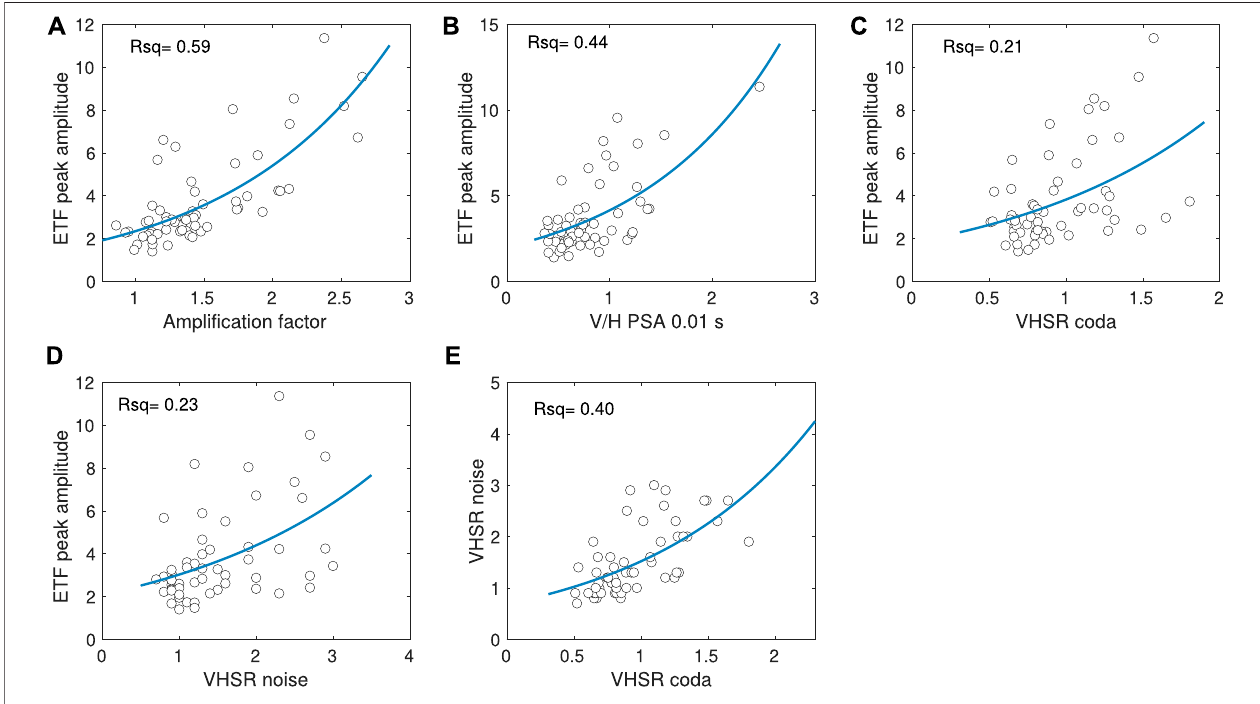
FIGURE 12 | Each panel depicts the correlation between the ETF and (A) Ampli fi cation factor from maximum amplitudes of earthquake records, (B) the V/H from pseudo-spectral accelerations at 0.01 s, (C) the coda-based peak amplitudes of the VHSR and (D) the noise-based peak amplitudes of the VHSR, and (E) the correlation between the VHSR coda and noise. Each blue line illustrates the fi tting function between the two